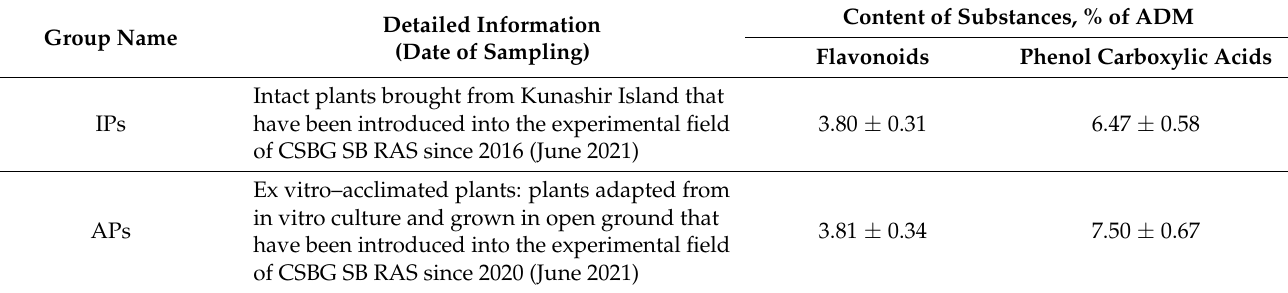
Table 1. Levels of flavonoids and phenol carboxylic acids in water-ethanol leaf extracts of S. betulifolia ssp. aemiliana introduced into the Central Siberian Botanical Garden (CSBG), the Siberian Branch of the Russian Academy of Sciences (SB